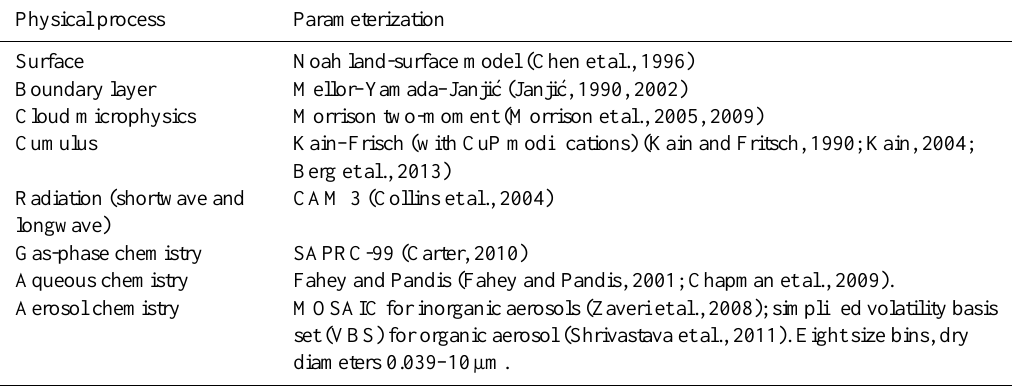
Table 1. WRF-Chem configuration used in this study.